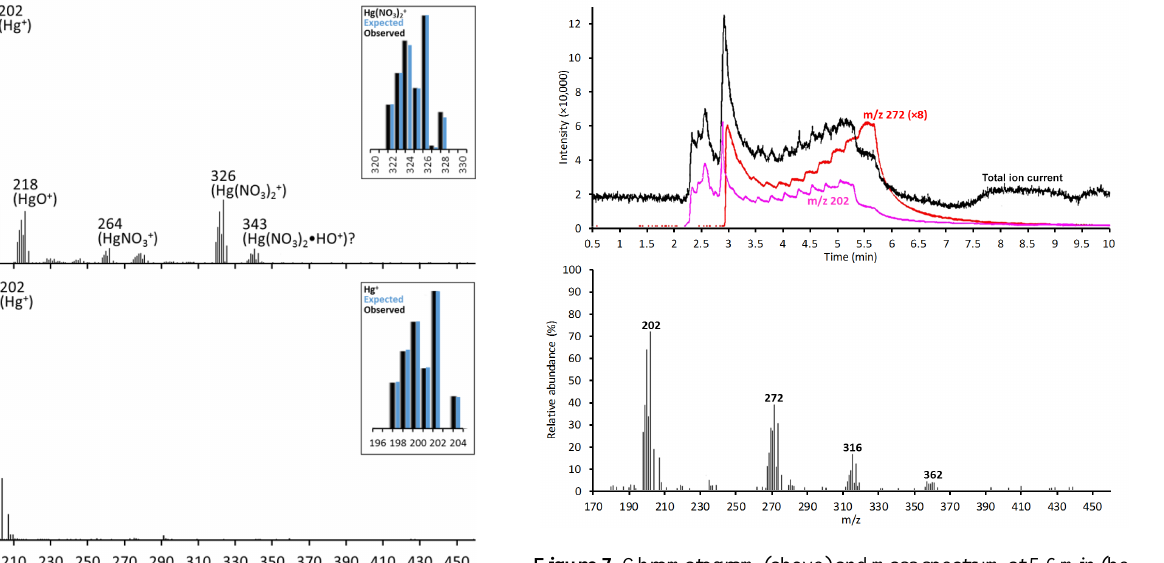
Figure 7. Chromatogram (above) and mass spectrum at 5.6min (be- low) of HgCl 2 permeated onto quartz wool-filled PFA tubing, then desorbed into the GC/MS